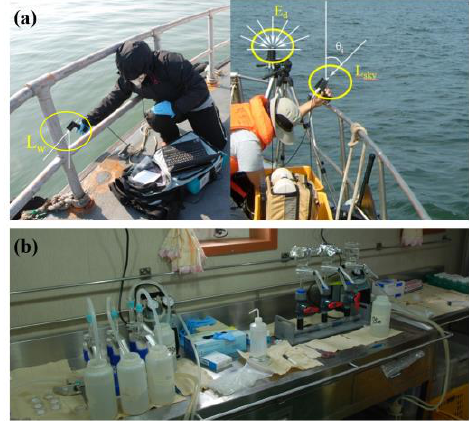
Figure 4 . In-situ field data measurements for (a) sea surface radiance and (b) environmental characteristics.